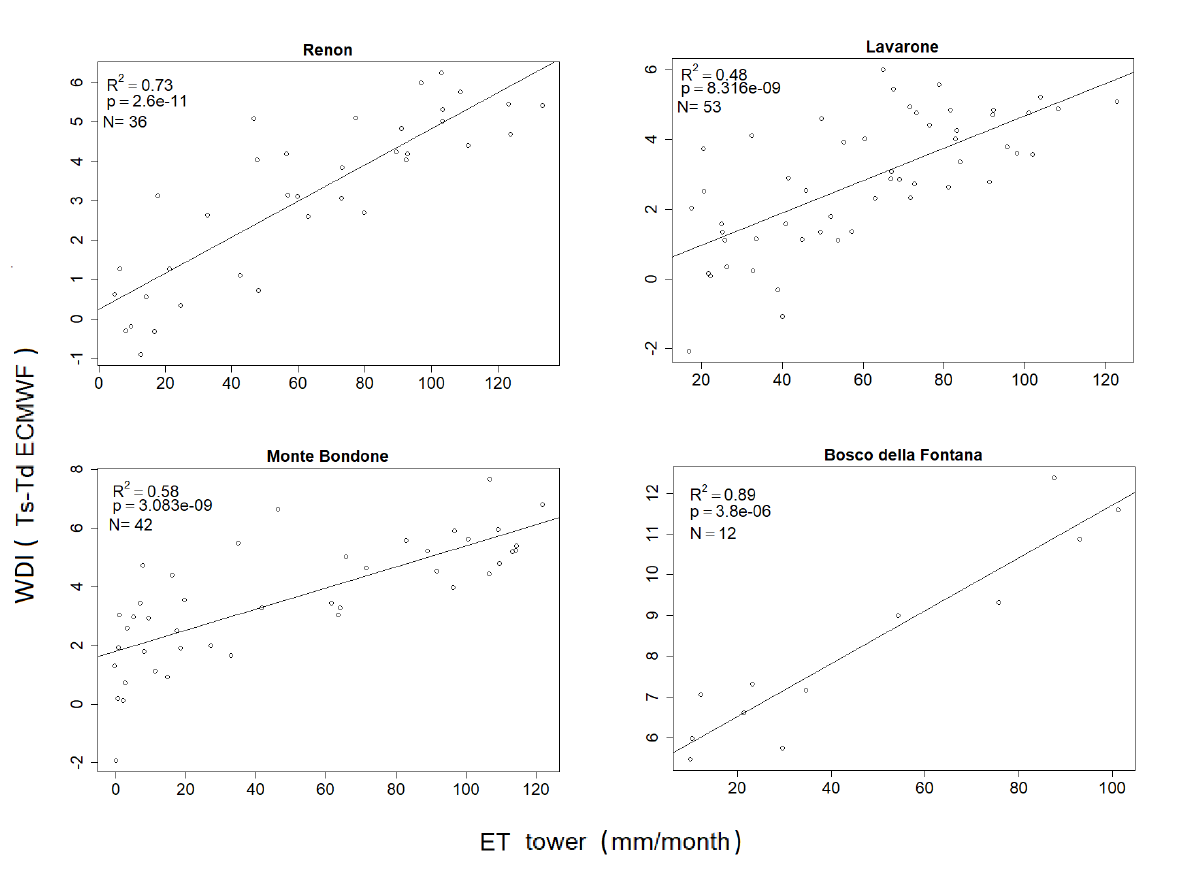
Figure 6. Linear regression between ET and WDI for the four considered study areas.